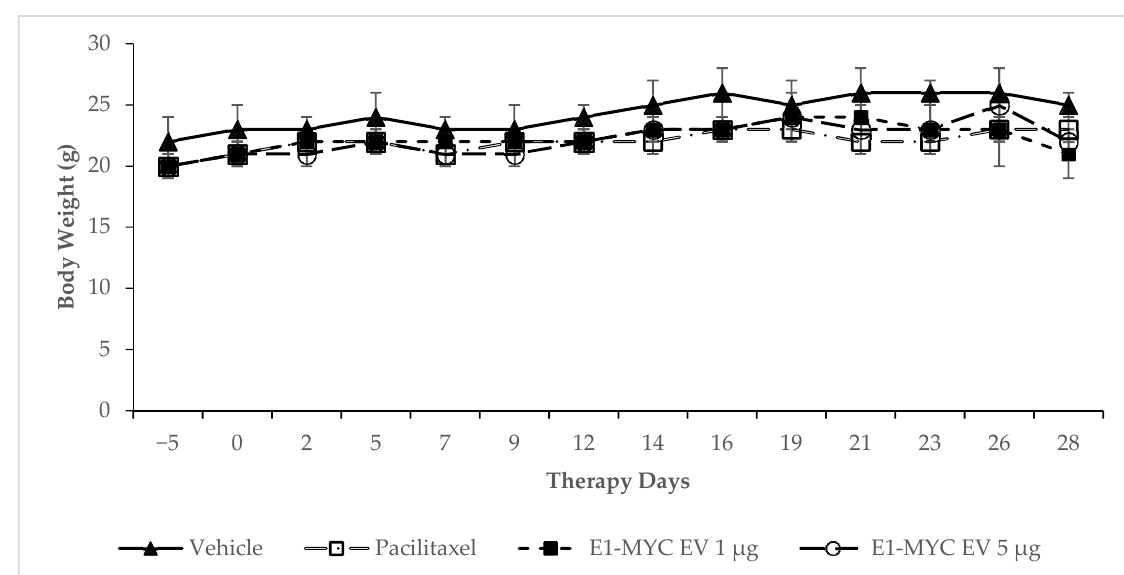
Figure 2. Effect of E1-MYC exosome on body weight. Mice were injected with either vehicle, Paclitaxel, or two different doses of E1-MYC exosome (1 µ g or 5 µ g), and their body weight was recorded thrice weekly. No statistically significant differences in body weight between the different treatment groups were observed. Results represent the mean ± SD, n = 8 for all groups from day 0 to day 16. Mice with tumor volume > 2000 mm 3 were euthanized and caused the n to gradually drop to 2 for the vehicle and exosome groups at day 28.